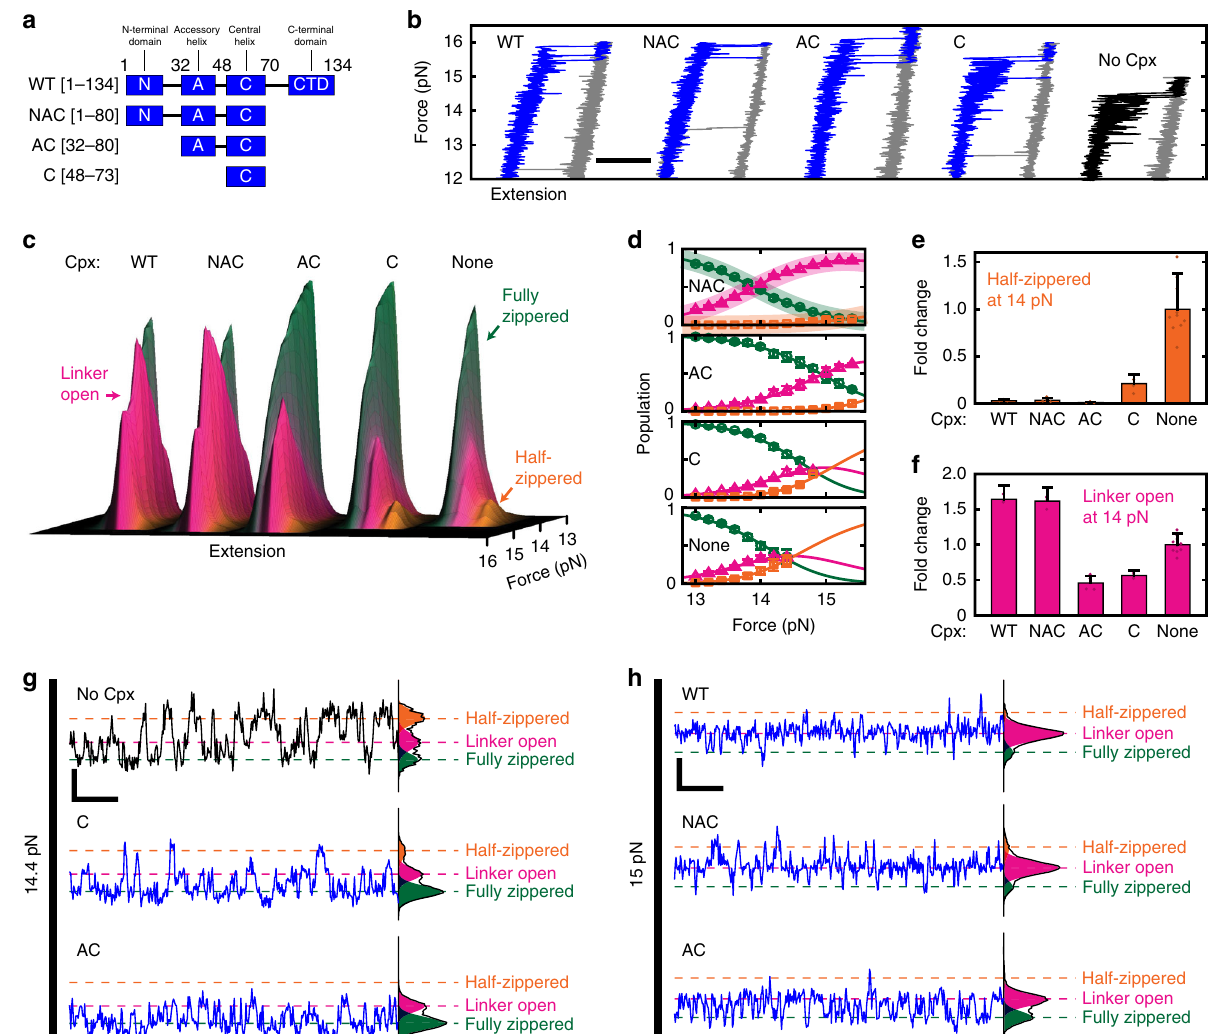
Fig. 5 Multiple domains of complexin collectively drives SNARE complexes into the linker-open conformation. a The domain structures of wild-type Cpx and its variants prepared in this study. b Force – extension curves for unzipping (blue/black) and rezipping (gray) of SNARE complexes in the presence of the indicated variants of Cpx (all at 5 μ M). Horizontal scale bar represents 20 nm. c Force-dependent evolution of extensions for the SNARE complex between 13 and 16 pN of force in the presence of the indicated variants of Cpx. d Force-dependent equilibria among the three zippered conformations. Solid lines represent the fi ts to a three-state equilibrium model (Supplementary Note 5). The curves for wild-type Cpx (WT) are overlaid as shades in the top panel with NAC for the sake of comparison. The color code is the same as in c . e , f Fold changes at 14 pN in the half-zippered ( e ) and linker-open ( f ) populations upon addition of each Cpx variant. In d – f , data are represented as mean ± s.d. of more than three measurements. g , h Representative time traces for the SNARE complexes in the presence of the indicated variants of Cpx. Vertical and horizontal scale bars represent 10 nm and 50